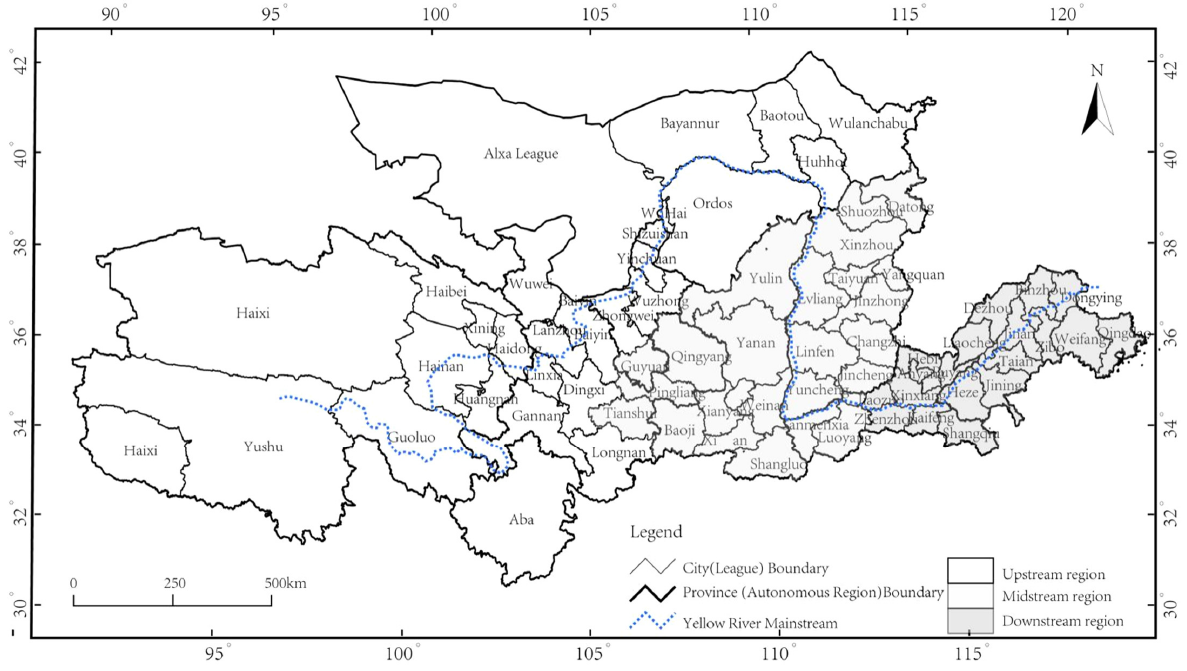
Figure 1. The scope of administrative divisions and the upstream, midstream, and downstream region of the Yellow River Basin. Note: This map has the approval number of GS (2016) No. 2556 and was downloaded from the 1:1 million national basic geographic database of the National Geographic Information Resource Catalog Service